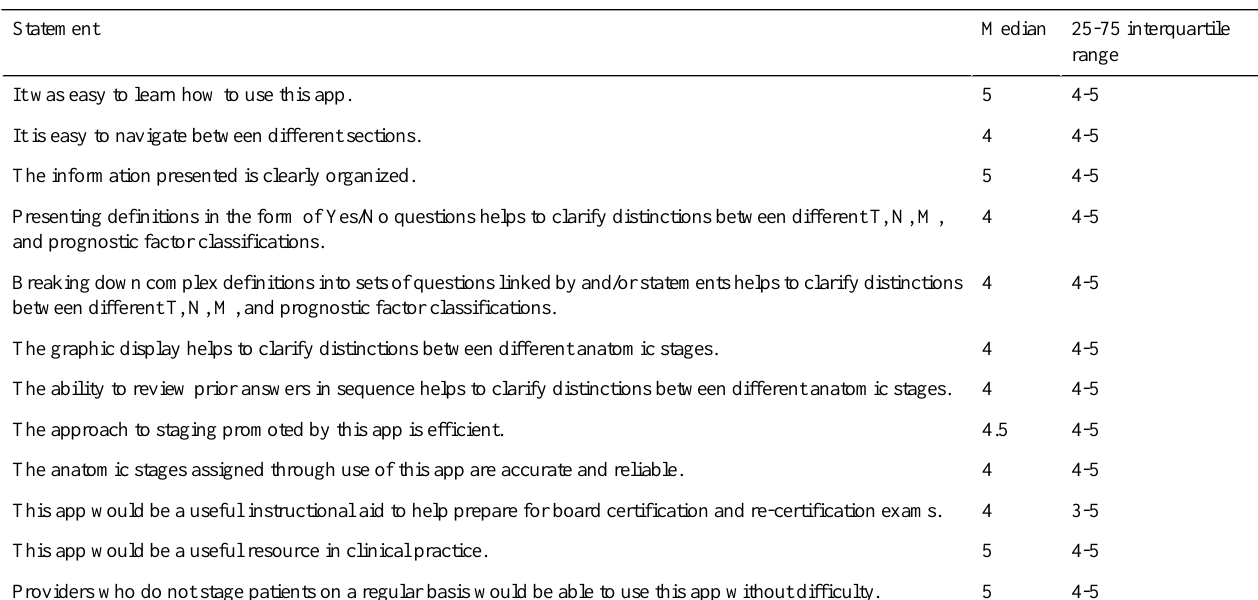
Table 4. Survey responses.